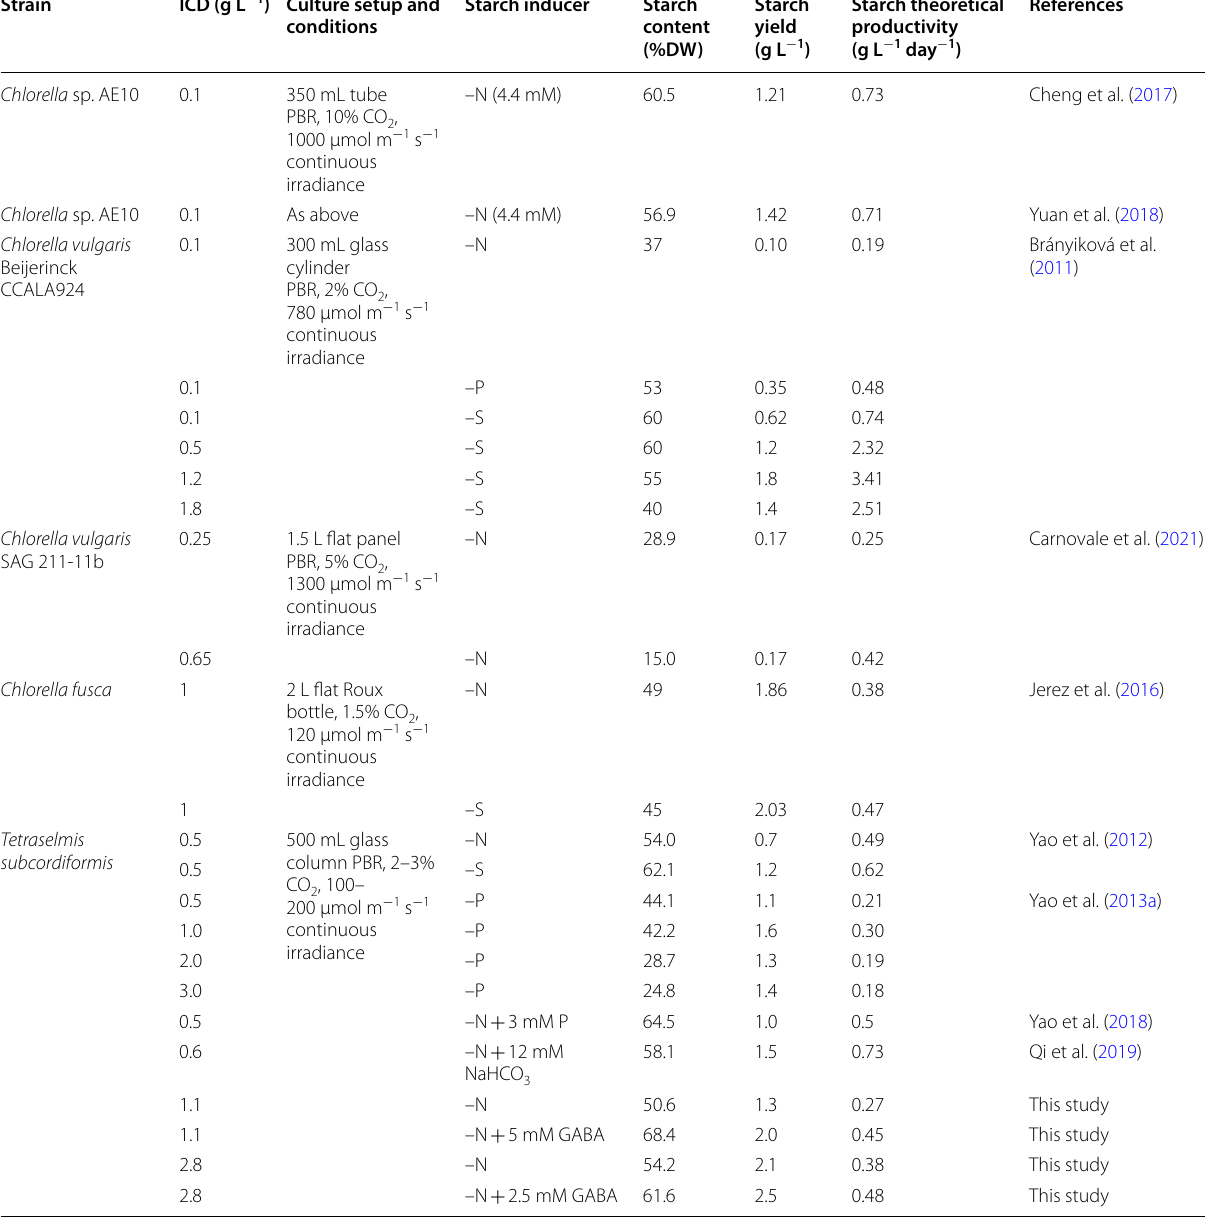
Table 2 Comparison of starch production in different microalgae under batch culture mode with different ICDs and nutrient deprivation